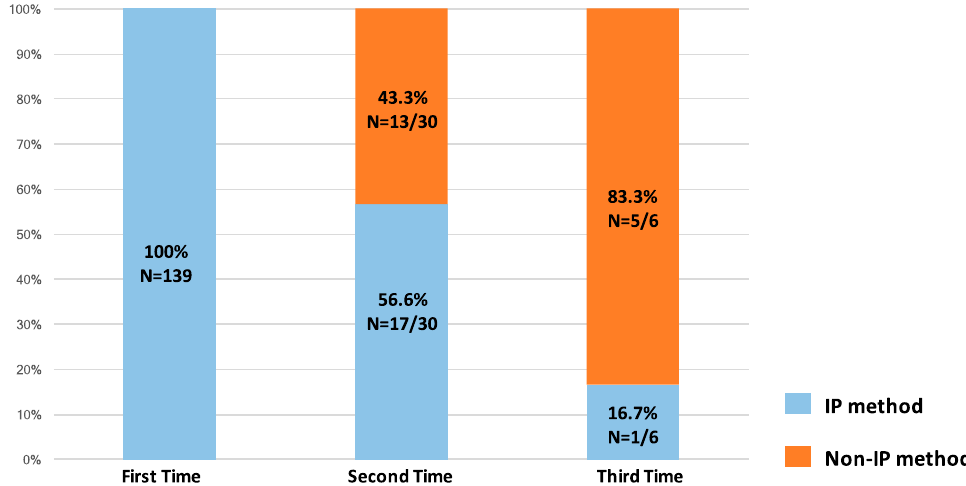
Figure 3. The proportion of use of interventional pulmonology (IP) and non-IP re-biopsy methods in first, second, and third